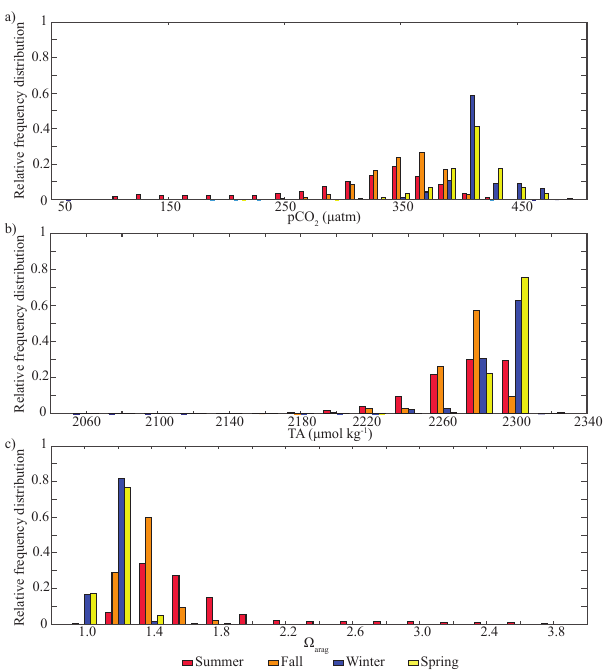
Figure 8. Seasonal variability in the inorganic carbon system. Rela- tive frequency distribution of (a) measured underway surface par- tial pressure p CO 2 (µatm), (b) predicted surface total alkalinity (TA, µmolkg − 1 ) from underway salinity, and (c) predicted sur- face aragonite saturation state ( (cid:127) arag ) in summer (red), fall (or- ange), winter (blue), and spring (yellow). The x axis represents the range of (cid:127) arag , TA, and p CO 2 with a relative frequency distribution ≥ 0 .